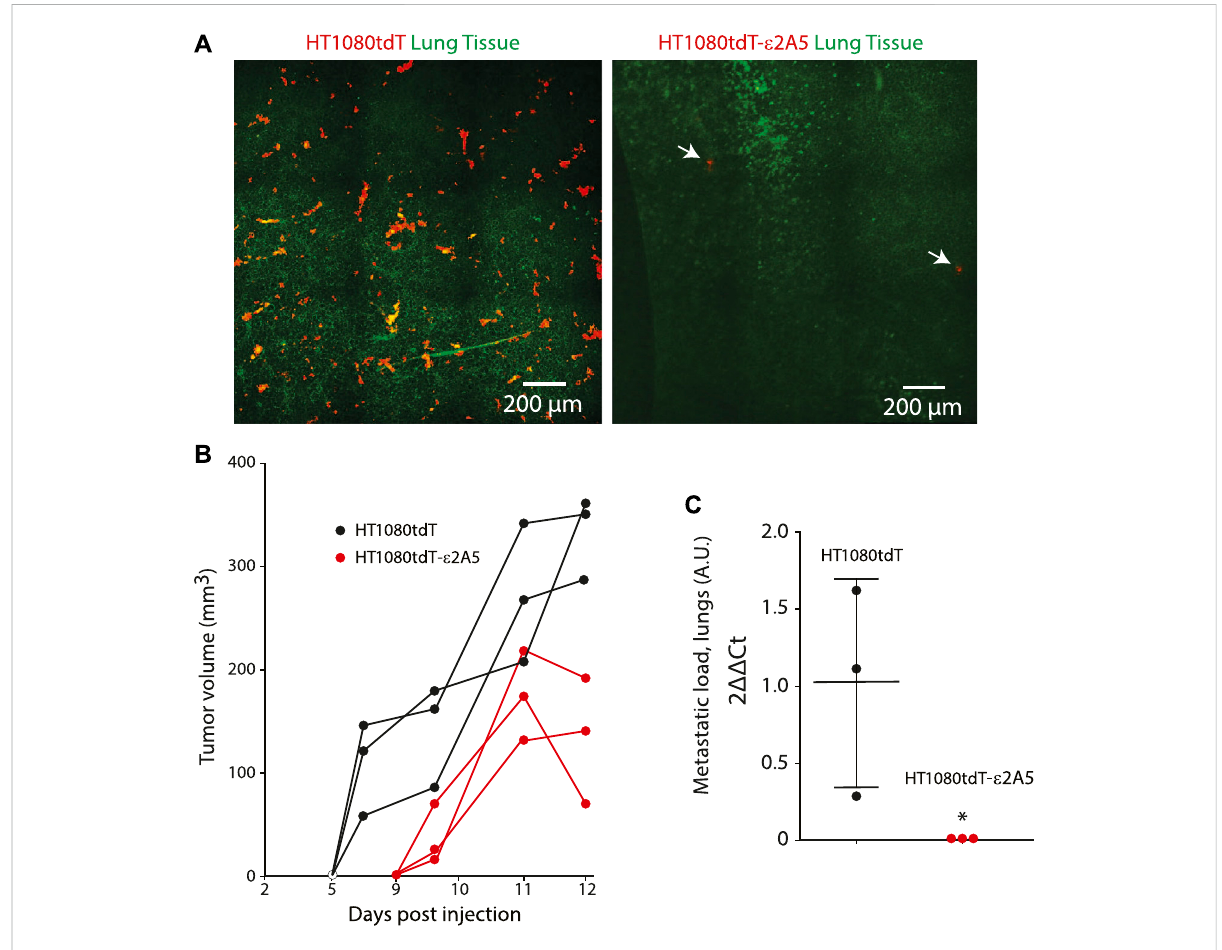
FIGURE 7 Xenograft murine model of spontaneous metastasis. (A) . Fluorescence stereomicroscopy images of lungs from mice bearing tumors derived from fi brosarcomaHT1080tdTcellsorHT1080tdT- ε 2A5cellsinjectedintothe fl ankofnudemice.HT1080-derivedcellsarevisibleasredcellsdueto stableexpressionofthetdTomatotransgene(Leongetal.,2014).ArrowsindicatethelocationoftwoHT1080tdT- ε 2A5cellsidenti fi edinlungofmice injected with HT1080tdT- ε 2A5 cells. (B) . Reduced tumor volume in HT1080tdT- ε 2A5 injected mice (n = 3). (C) . Quantitation of the metastatic lesions, as identi fi ed by presence of human Alu elements, formed by the HT1080tdT and HT1080tdT- ε 2A5cells. * p < 0.0001, n =